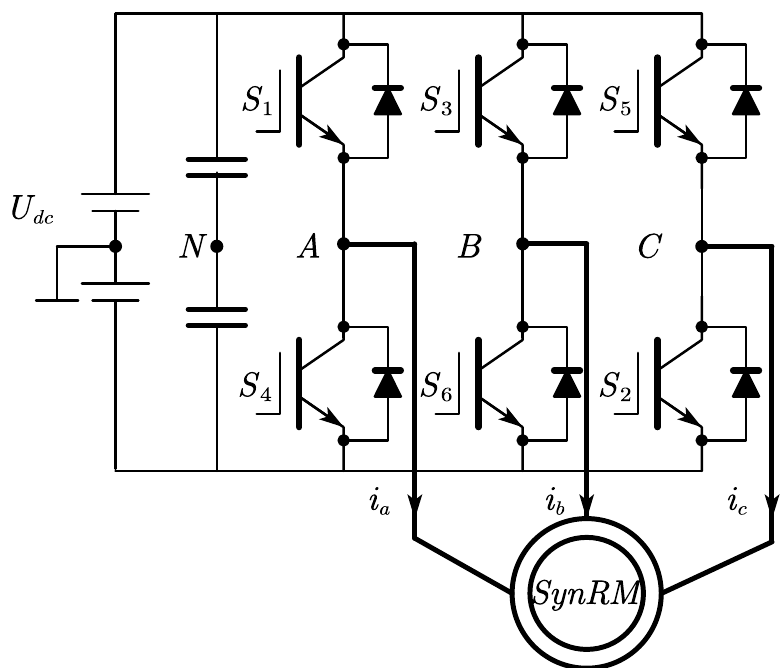
Figure 3. A three-phase PWM voltage-source inverter with SynRM load. The dead-time effect will cause a series of distorted voltage pulses, and the vector direction of the pulse is related to the polarity of the phase current. According to the voltage equivalent principle, these voltage pulses can be equivalent to a 180 ◦ conducting square wave, shown in Figure 4. Since the three-phase currents differ by 120 ◦ from each other, six error voltage vectors are formed in the motor winding [22].